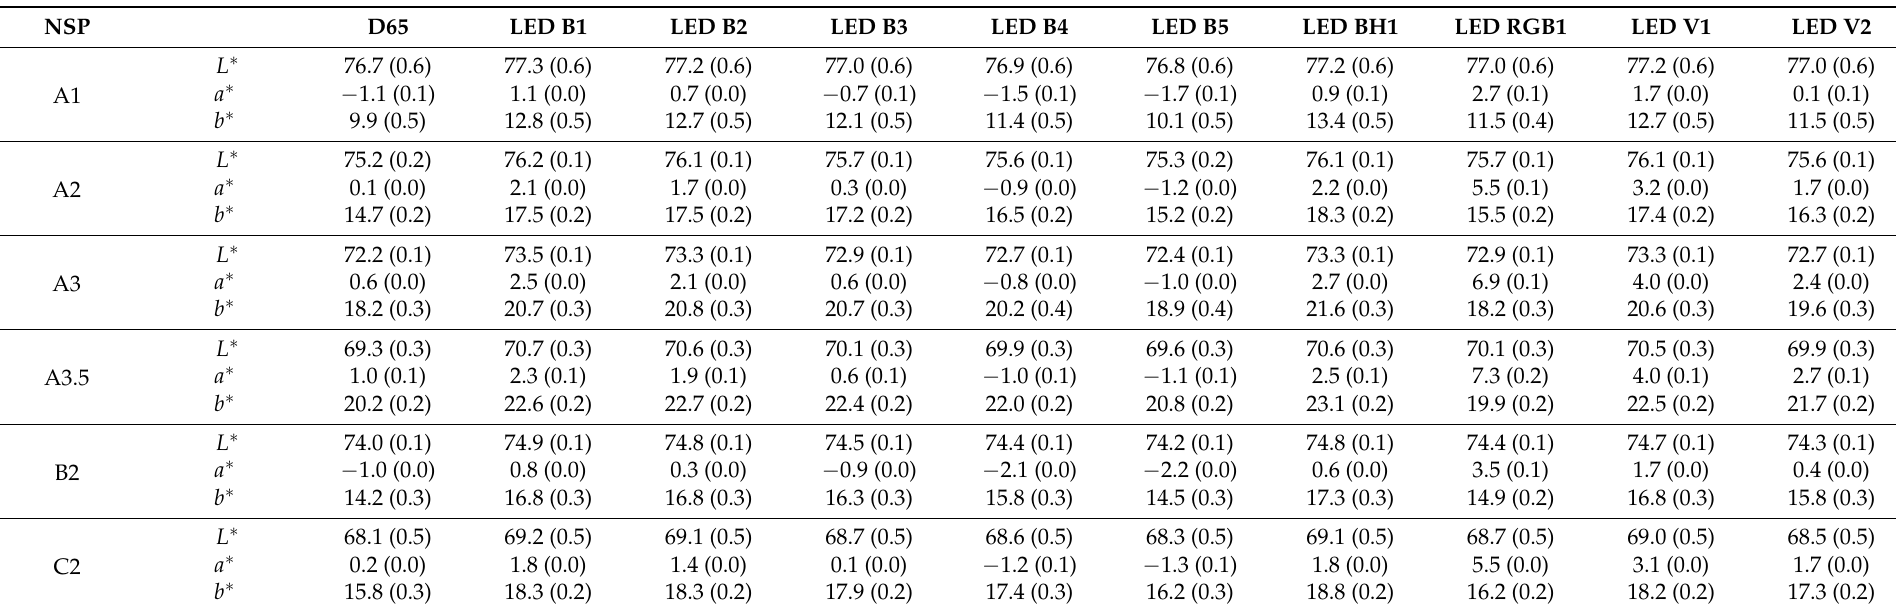
Table 3. Mean CIELAB color coordinate values and standard deviations (in parentheses) for the NSP ceramic shades under D65 and nine LED illuminants (corresponding colors under D65 illuminant and CIE 1931 standard colorimetric